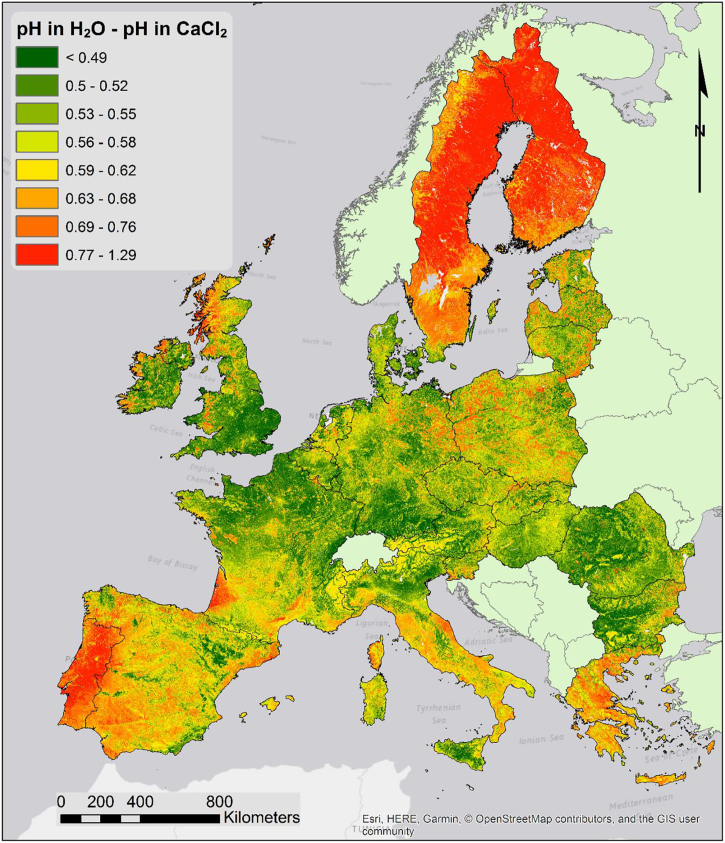
Map of the difference between pH in water and pH in CaCl2 0.01 M solution.